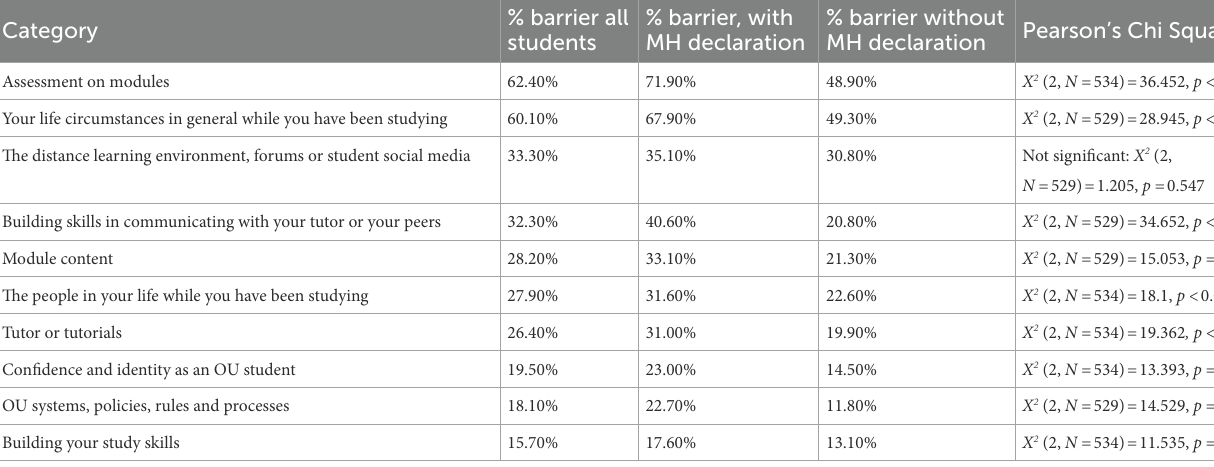
% barrier all students